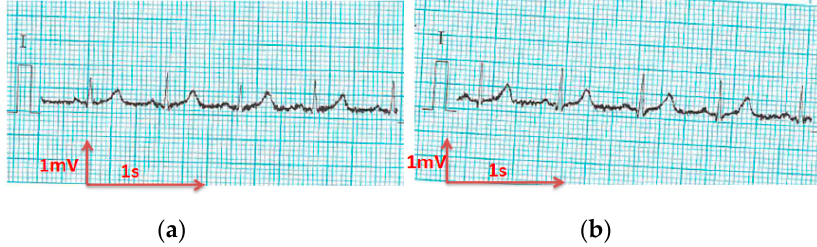
Figure 13. ECG signal obtained by cotton/Lycra electrodes with 11.9 wt.% PEDOT:PSS: ( a ) before washing; ( b ) after 50 washing cycles.